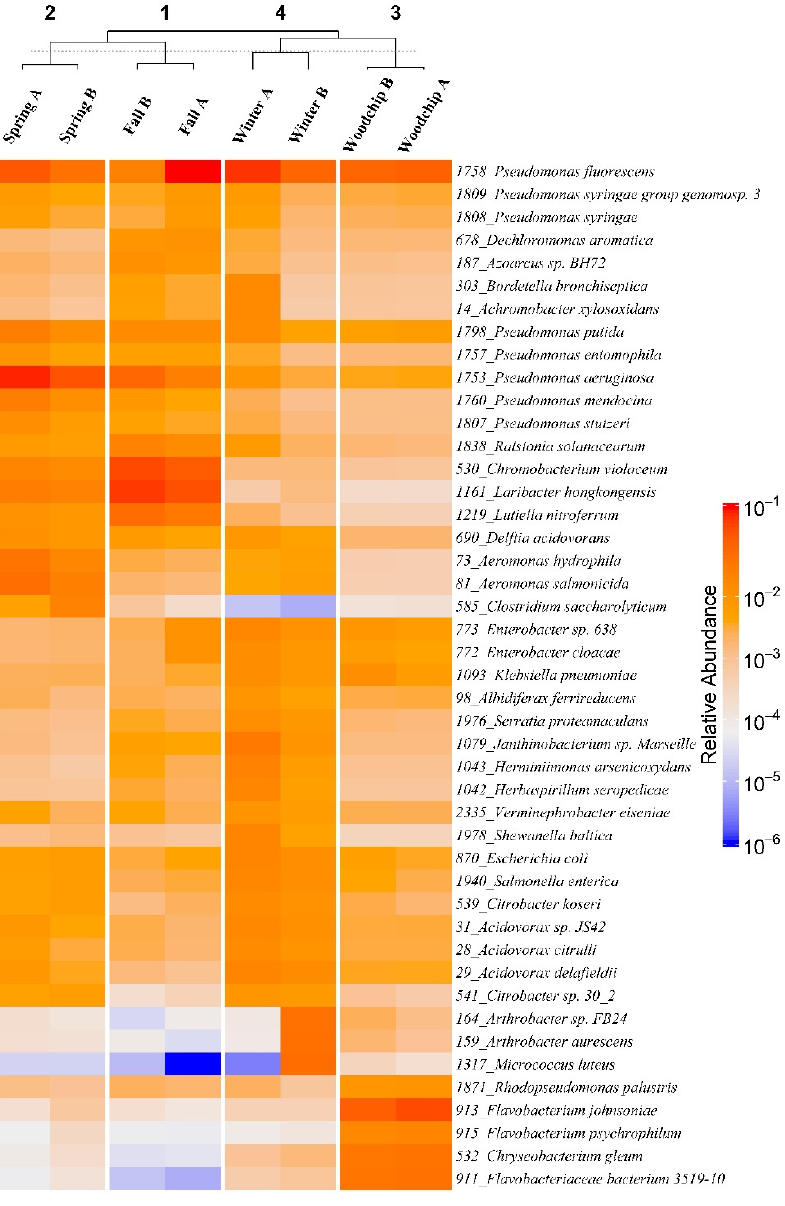
Figure 3. Heatmap and cluster analysis of enrichments (spring, fall, and winter) and native woodchip samples (fall) based on the 45 relatively most abundant bacterial species. The A and B notations refer to biological replicates. Each row of the heatmap displays the abundance of an Operational Taxonomic Unit (OTU) for which the corresponding number and the identified species are displayed on the right-hand side. The number on top of the figures represents the different clusters identified with k-means clustering (k = 4).